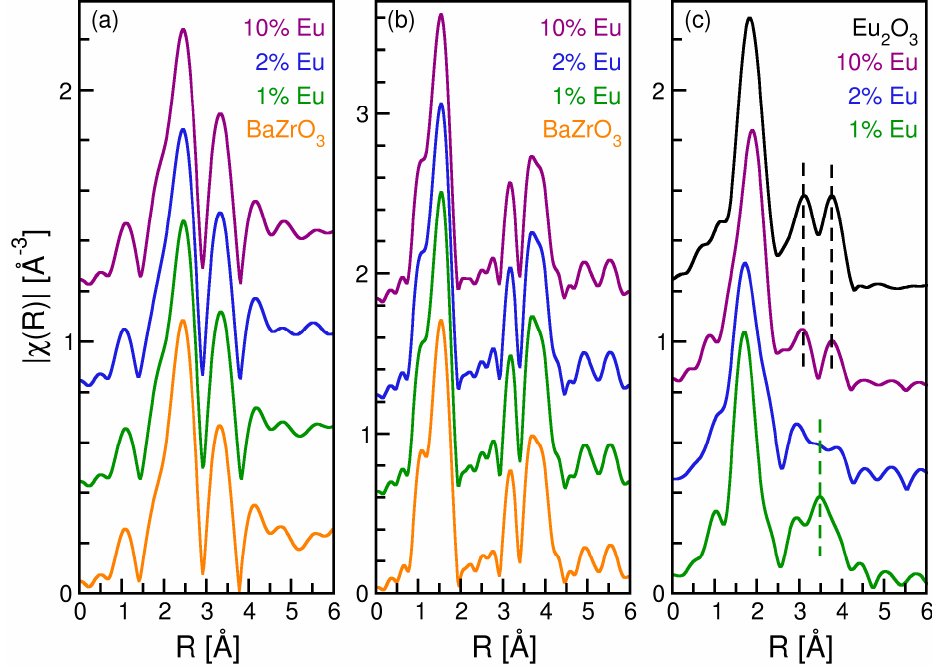
Figure 3. Fourier transformed spectra of the BZOE samples and standards at the ( a ) Ba L 3 edge, ( b ) Zr K edge, and ( c ) Eu L 3 edge. Spectra are shifted vertically for clarity. Table 2. Values of the amplitude reduction factor ( S 02 ) or path degeneracy (N), bond length, and disorder factor for the near neighbor paths obtained from EXAFS analysis of the BZO and BZOE samples at the Ba L 3 , Zr K, and Eu L 3 edges.